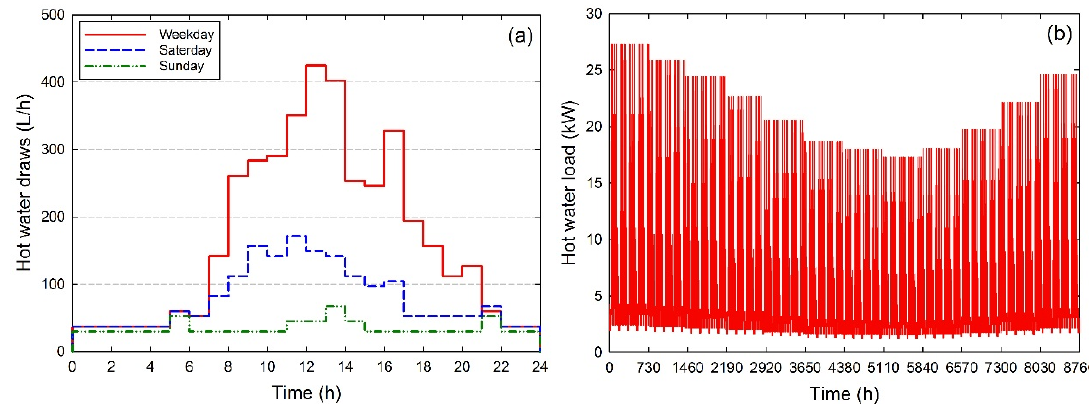
Figure 3. ( a ) Hourly hot water consumption rates over one day; and ( b ) hot water load over one year in the building considered for the case studies.